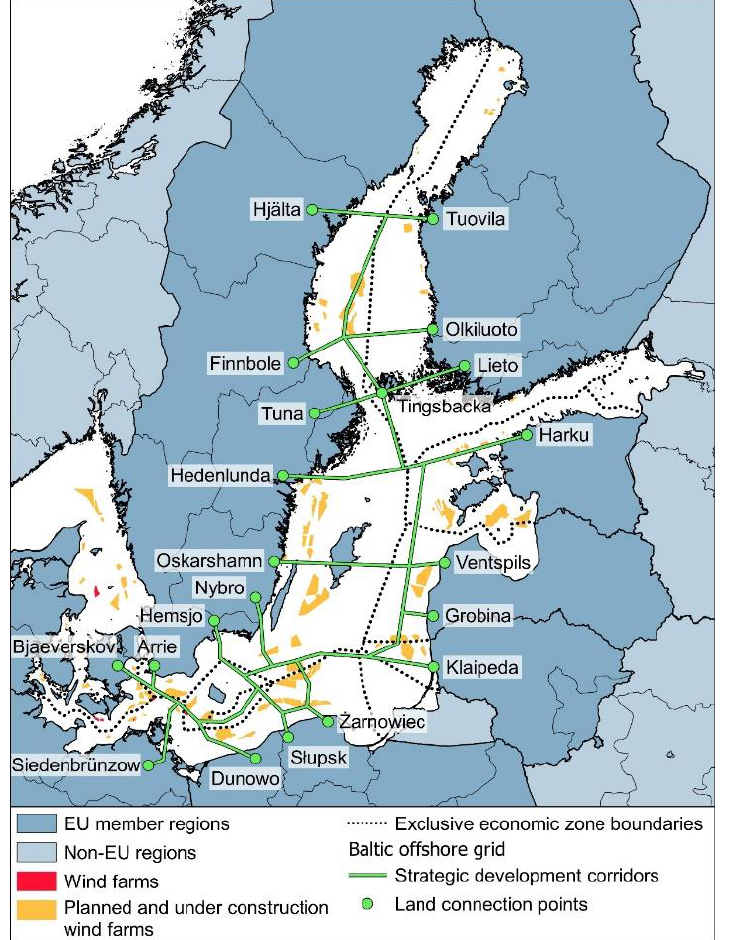
Figure 16. Baltic Offshore Grid (BOG 2050) concept. Source: own study based on [67].